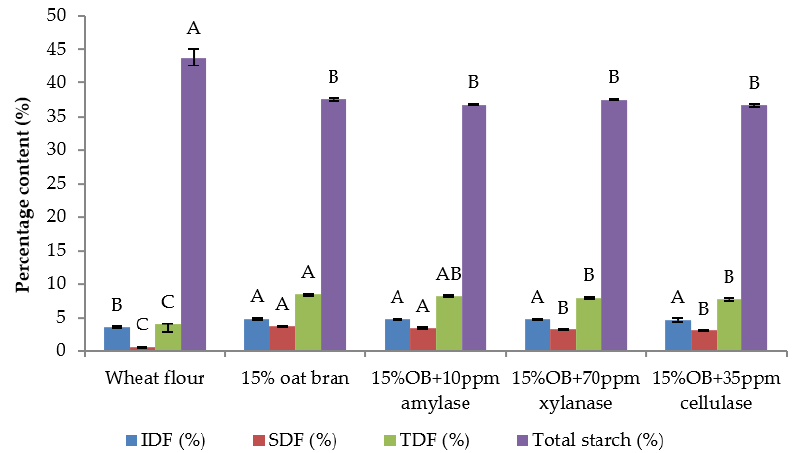
Figure 3. Cell density and cell size of Chinese steamed bread slices. Values with different letters differ significantly ( p < 0.05).